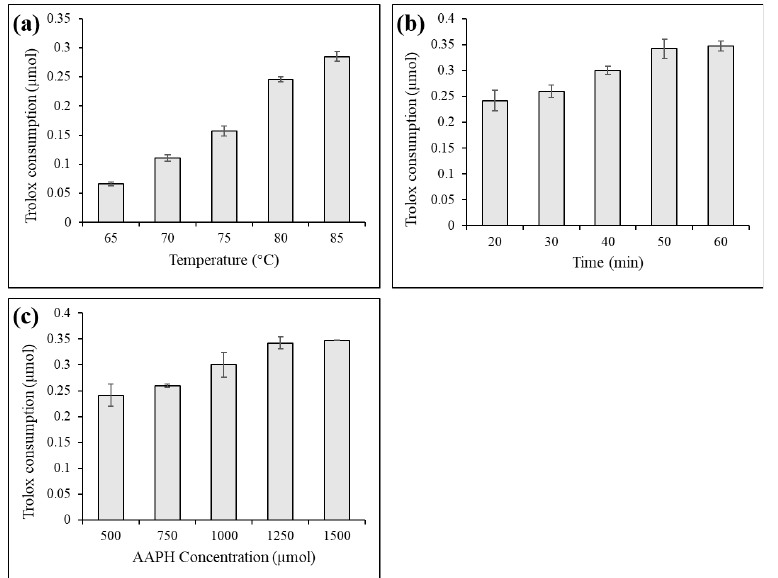
Figure 1. Effects of bath temperature ( a ), heating time ( b ) and AAPH concentration ( c ) on AAPH radical production.